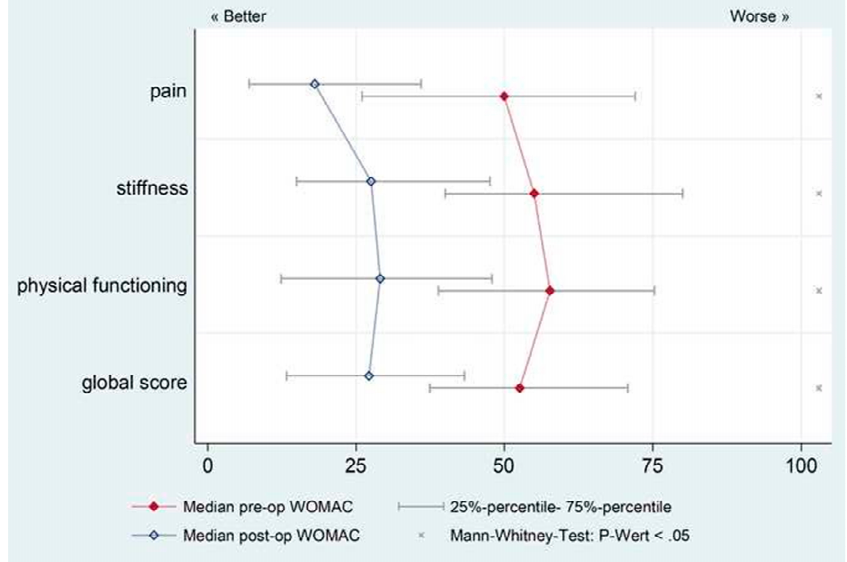
Figure 2. Western Ontario McMasters Osteoarthritis Score (WOMAC) scores showed a significant improvement ( p < 0.05) postoperatively compared with preoperative scores at a mean follow-up of 4.2 years (range, 1.1–8.9 years). The median preoperative WOMAC score was 52.5 (IQR: 33.3), and the median postoperative WOMAC score was 27.2 (IQR: 30) . IQR: Inter Quartile